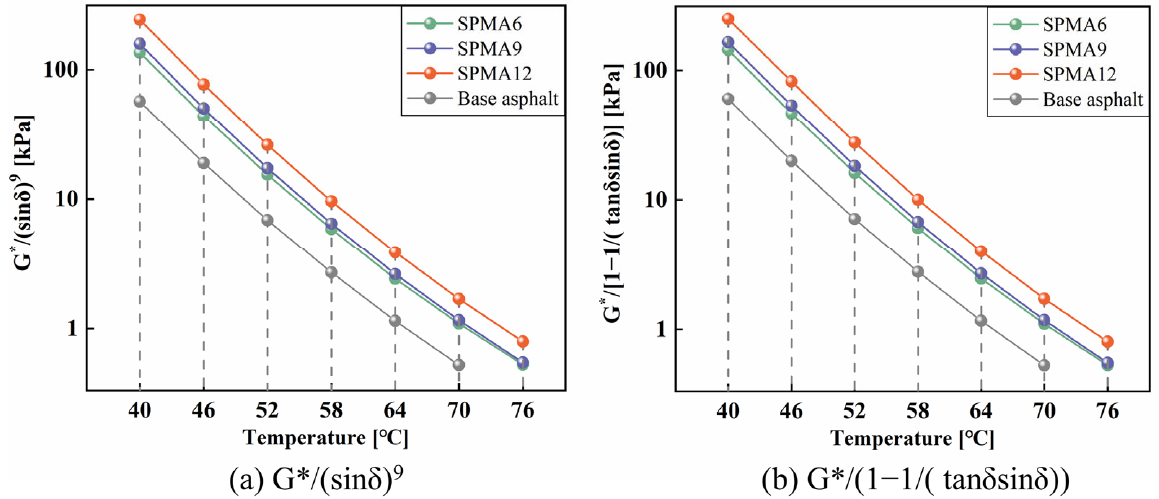
Figure 9. Improved rutting factor.